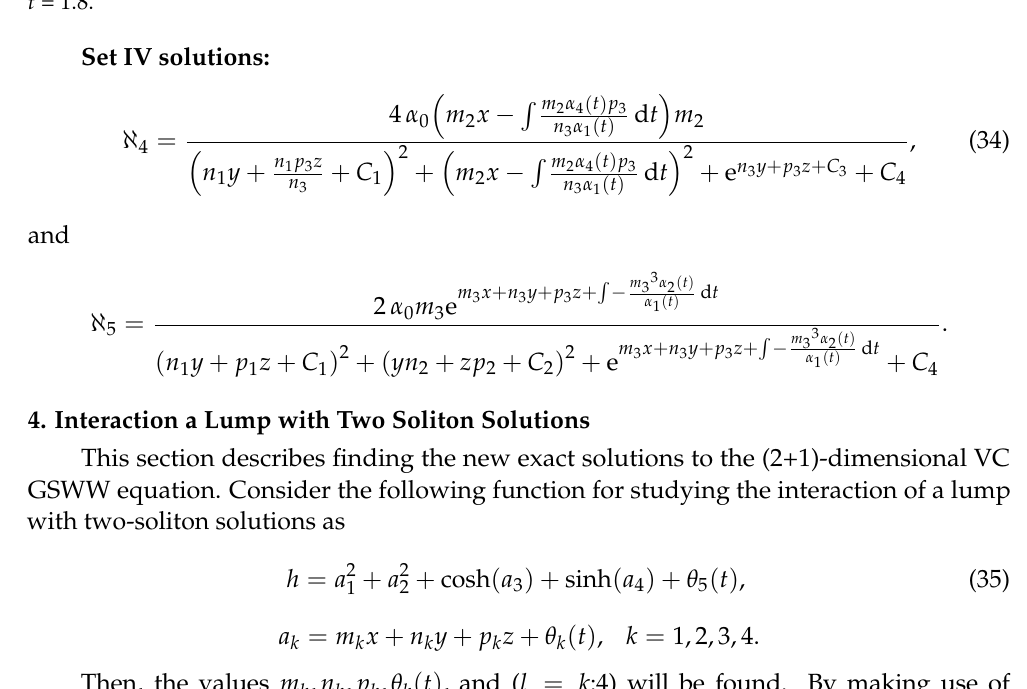
Figure 3. Plot of lump one-soliton solution (31) ( Γ 2 ) such as density plot for three times t = 0,1,1.8, respectively, sub figures ( f1 , f4 , f7 ) for t = 0, sub figures ( f2 , f5 , f8 ) for t = 1, and sub figures ( f3 , f6 , f9 ) for t =